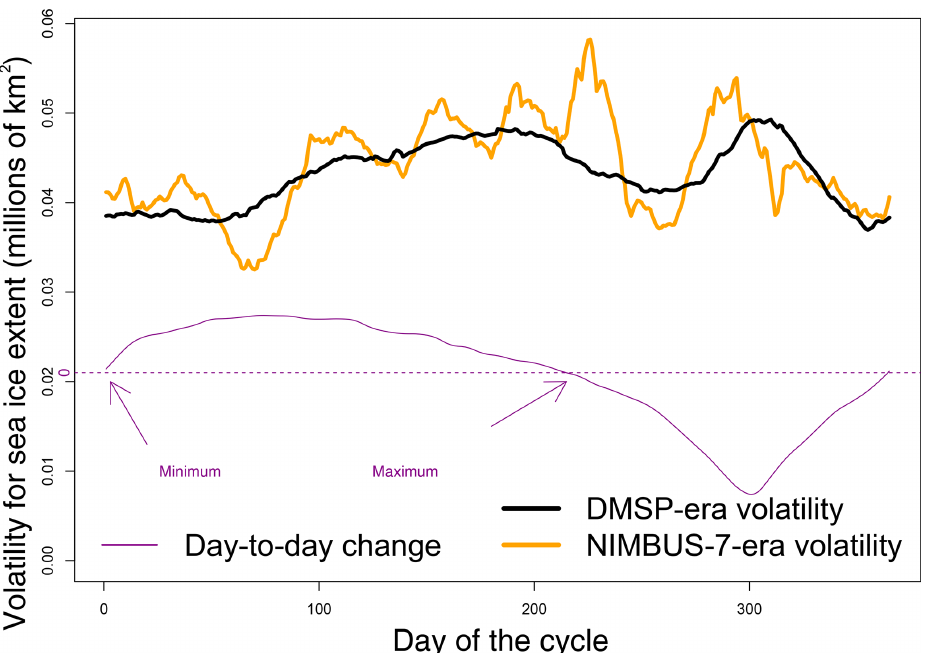
Figure 3. Volatility of the recorded SIE for the NIMBUS-7 era (26 October 1978 to 20 August 1987) and the DMSP era (21 August 1987 to 2018). It is averaged over each day of the cycle in these eras. The units are given in millions of square kilometers. The purple curve is the day-to-day change in SIE from Fig.